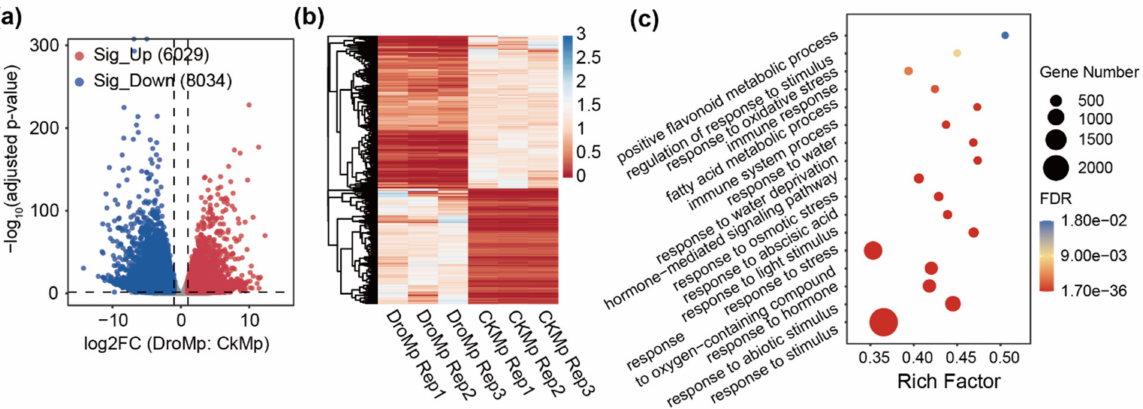
Figure 4. Differential gene expression in M. prunifolia in response to drought treatment. ( a ) Volcano plot showing up-regulated genes and down-regulated genes in M. prunifolia after drought treatment. ( b ) Heat map of differentially expressed genes (DEGs). ( c ) GO enrichment analysis of DEGs. Sig_Up, up-regulated genes; Sig_Down, down-regulated genes; DroMp, M. prunifolia seedlings were treated with drought stress; CKMp, M. prunifolia seedlings were grown under control condition; FDR, false discovery